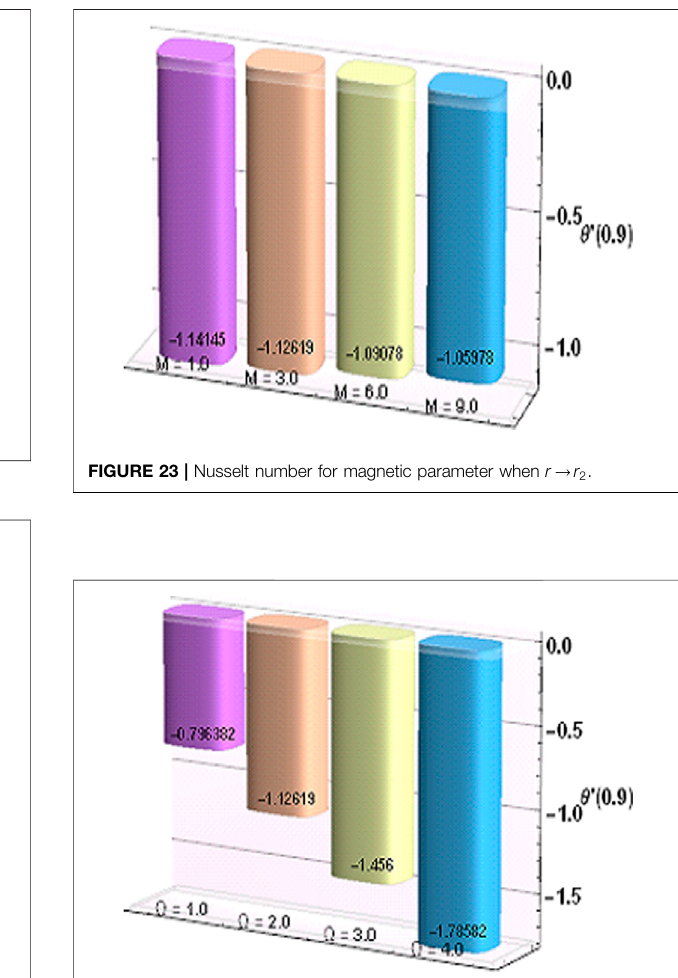
FIGURE 22 | Temperature for cilia length parameter at r (cid:1) 0.3.